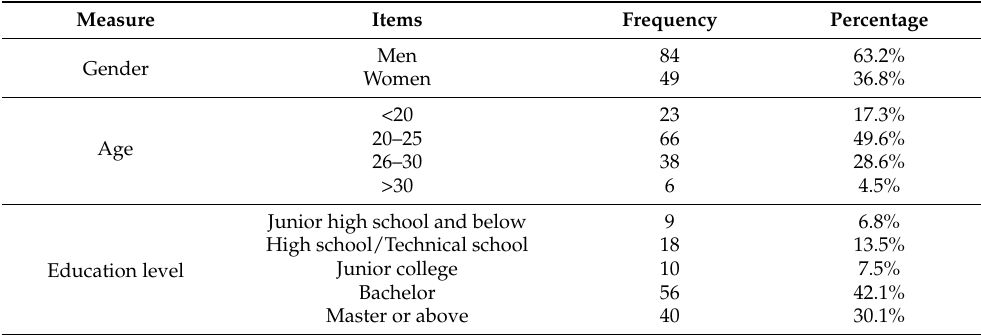
Table 1. Sociodemographic information ( n =